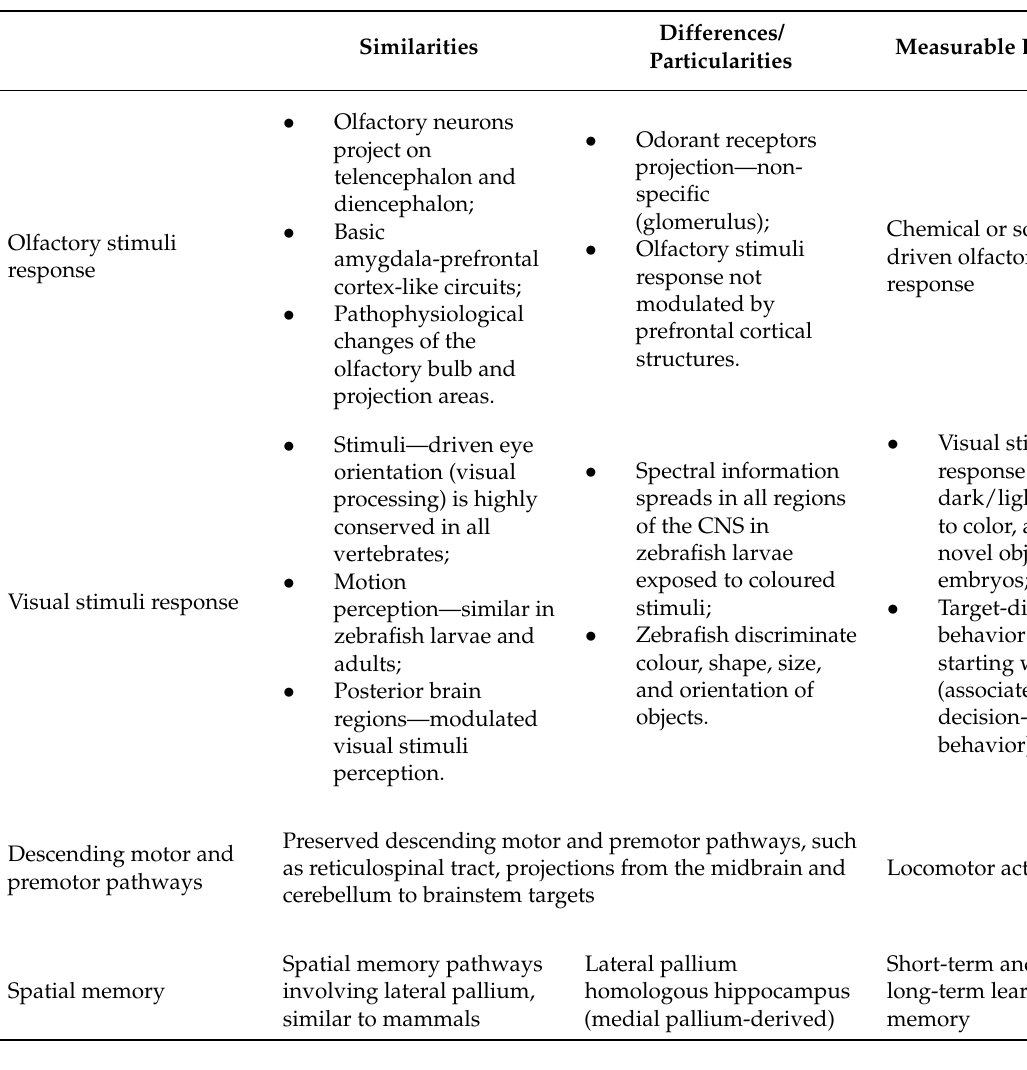
Table 1. Similarities and differences between zebrafish and